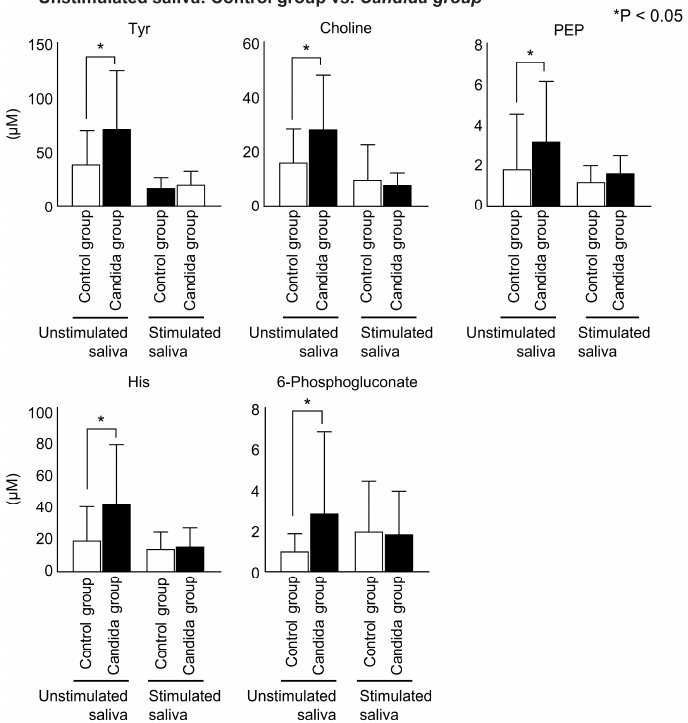
Figure 4. Inter-group comparison of metabolites detected in participants’ unstimulated saliva. Salivary metabolites in the Candida group and control group were compared using the Mann–Whitney test. Significant differences were found between five metabolites in unstimulated saliva.